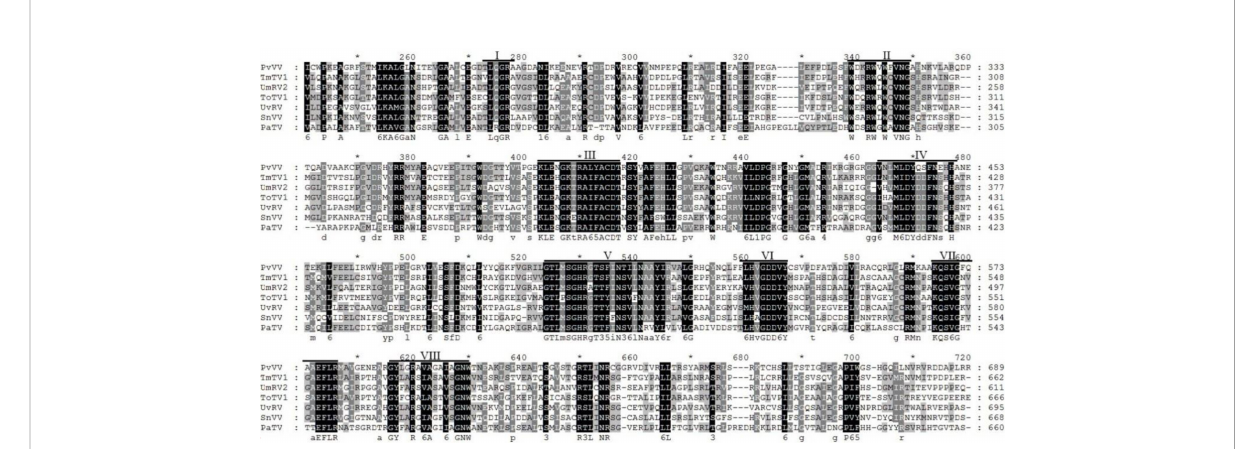
FIGURE 15 Multiple sequence alignment of the aa sequences of the RdRp domains of PvVVL1 and other similar victoriviruses using the ClustalX program and highlighted using the GeneDoc program. The conserved motifs in these RdRps are indicated by Roman numerals I to